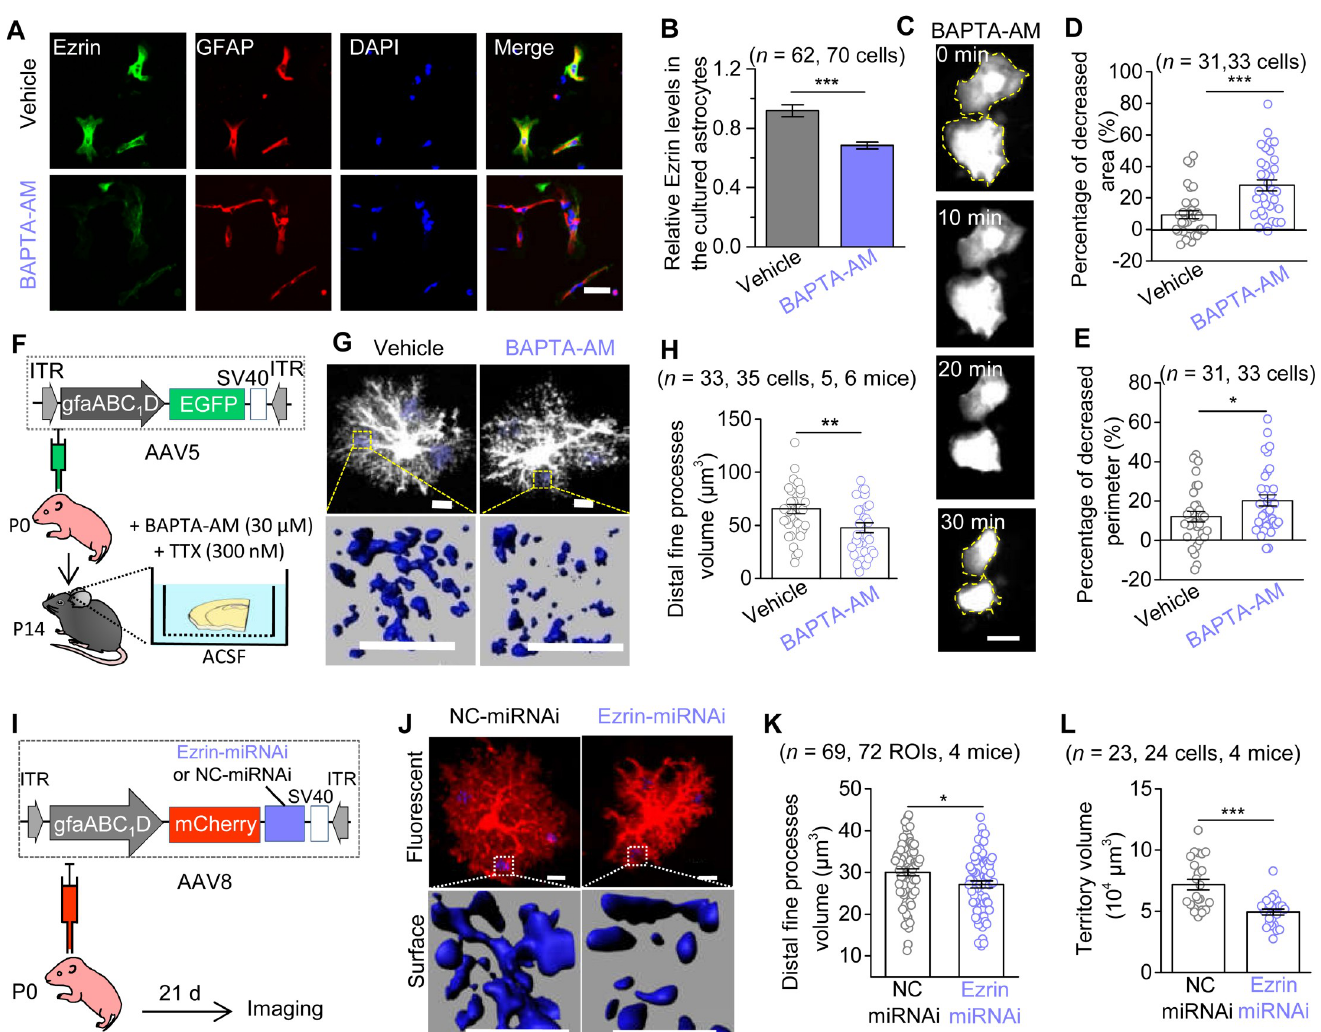
Fig 5. Reducing astrocyte intracellular Ca 2+ leads to the down-regulation of Ezrin, which produces morphological deficits. ( A )Representative immunofluorescence images of Ezrin in the primary cultured astrocytes after 1-h incubation with Vehicle (DMSO) or BAPTA-AM (30 μ M). Scale bars, 50 μ m. ( B )Quantification of relative fluorescent intensity of Ezrin ( n = 3 independent preparations; P < 0.001, Mann-Whitney test). ( C )Representative successive imaging of EGFP-labeled astrocytes during BAPTA-AM (30 μ M)incubation. Scale bars, 50 μ m.( D, E )Quantification cultured astrocytes morphology ( n = 3 independent preparations; D : P < 0.001, Mann-Whitney test; E : P = 0.041, unpaired t test). ( F )Diagram illustrates the vector construction, AAV injection in neonate mice, and protocol for brain slices incubation. ( G )Representative fluorescent images and 3D reconstructed distal fine processes of astrocytes within a 10 by 10 by 10 μ m 3 ROI, 3 ROIs for one cell. Scale bars, 10 μ m.( H )Quantification of astrocyte distal fine processes ( P = 0.006, unpaired t test). ( I )The vector construction of AAV8 � gfaABC 1 D � mCherry � Ezrin•miRNAi (or NC-miRNAi) and stereotactic injection of AAVs into P0 mice. ( J )Confocal images and 3D reconstructed astrocytes. ( K )Quantification of astrocytic distal fine processes volume in NC-miRNAi and Ezrin-miRNAi mice at P21 ( P = 0.018, unpaired t test). Scale bars, 10 μ m.( L )Quantification of astrocyte territory volume ( P < 0.001, unpaired t test). � P < 0.05, �� P < 0.01, ��� P < 0.001. Data are shown as mean ± SEM. Underlying data are available in S1 Data.AAV, adeno-associated virus; BAPTA-AM, 1,2-bis-(o-aminophenoxy)-ethane-N,N,N0 N0-tetraacetic acid, tetra-acetoxymethyl ester; EGFP, enhanced green fluorescent protein; GFAP, glial fibrillary acidic protein; ITR, inverted terminal repeat; miRNAi, microRNA-based RNA interference; NC, negative control; ROI, region of interest.